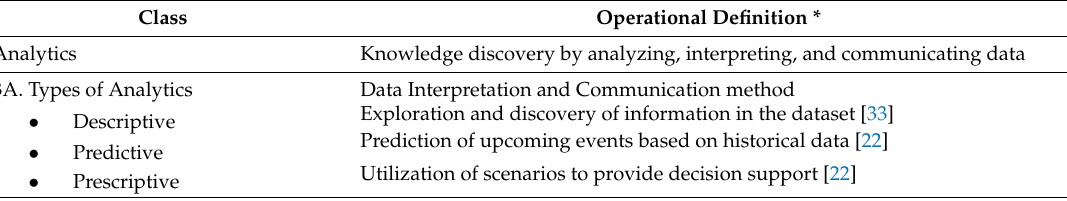
Table 3. Operational definition of the